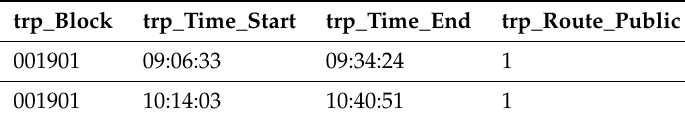
Table 5. Sample of the Trip